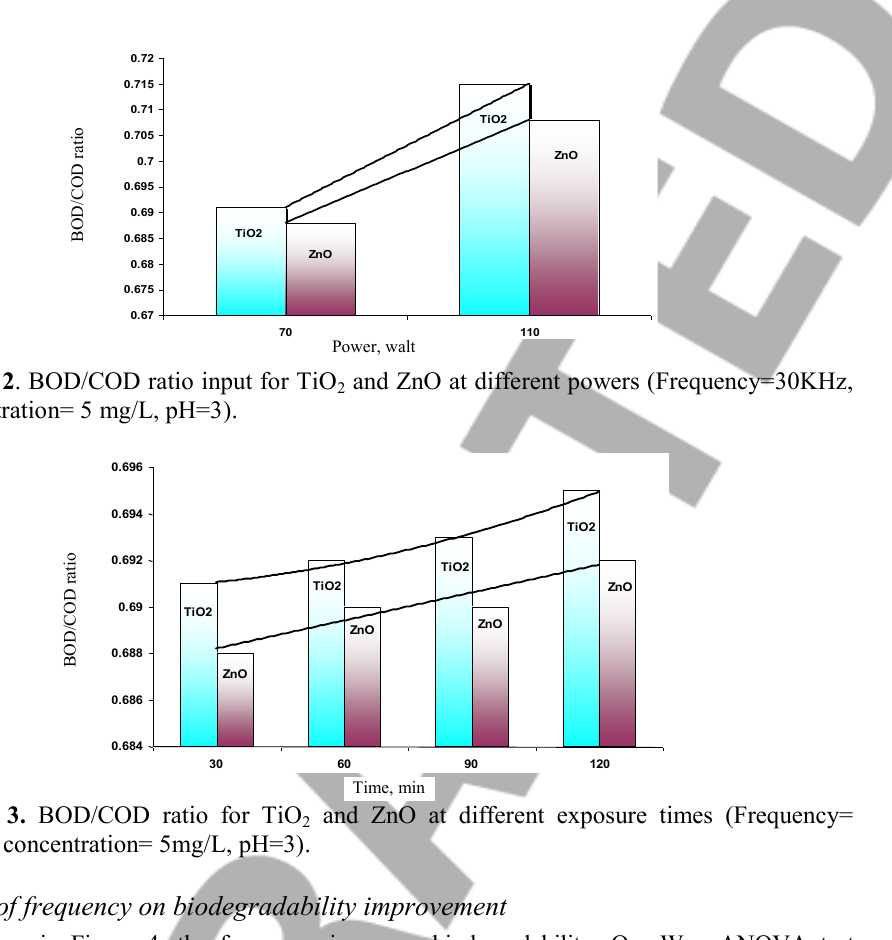
Figure 3. BOD/COD ratio for TiO 30Khz, concentration= 5mg/L, pH=3).